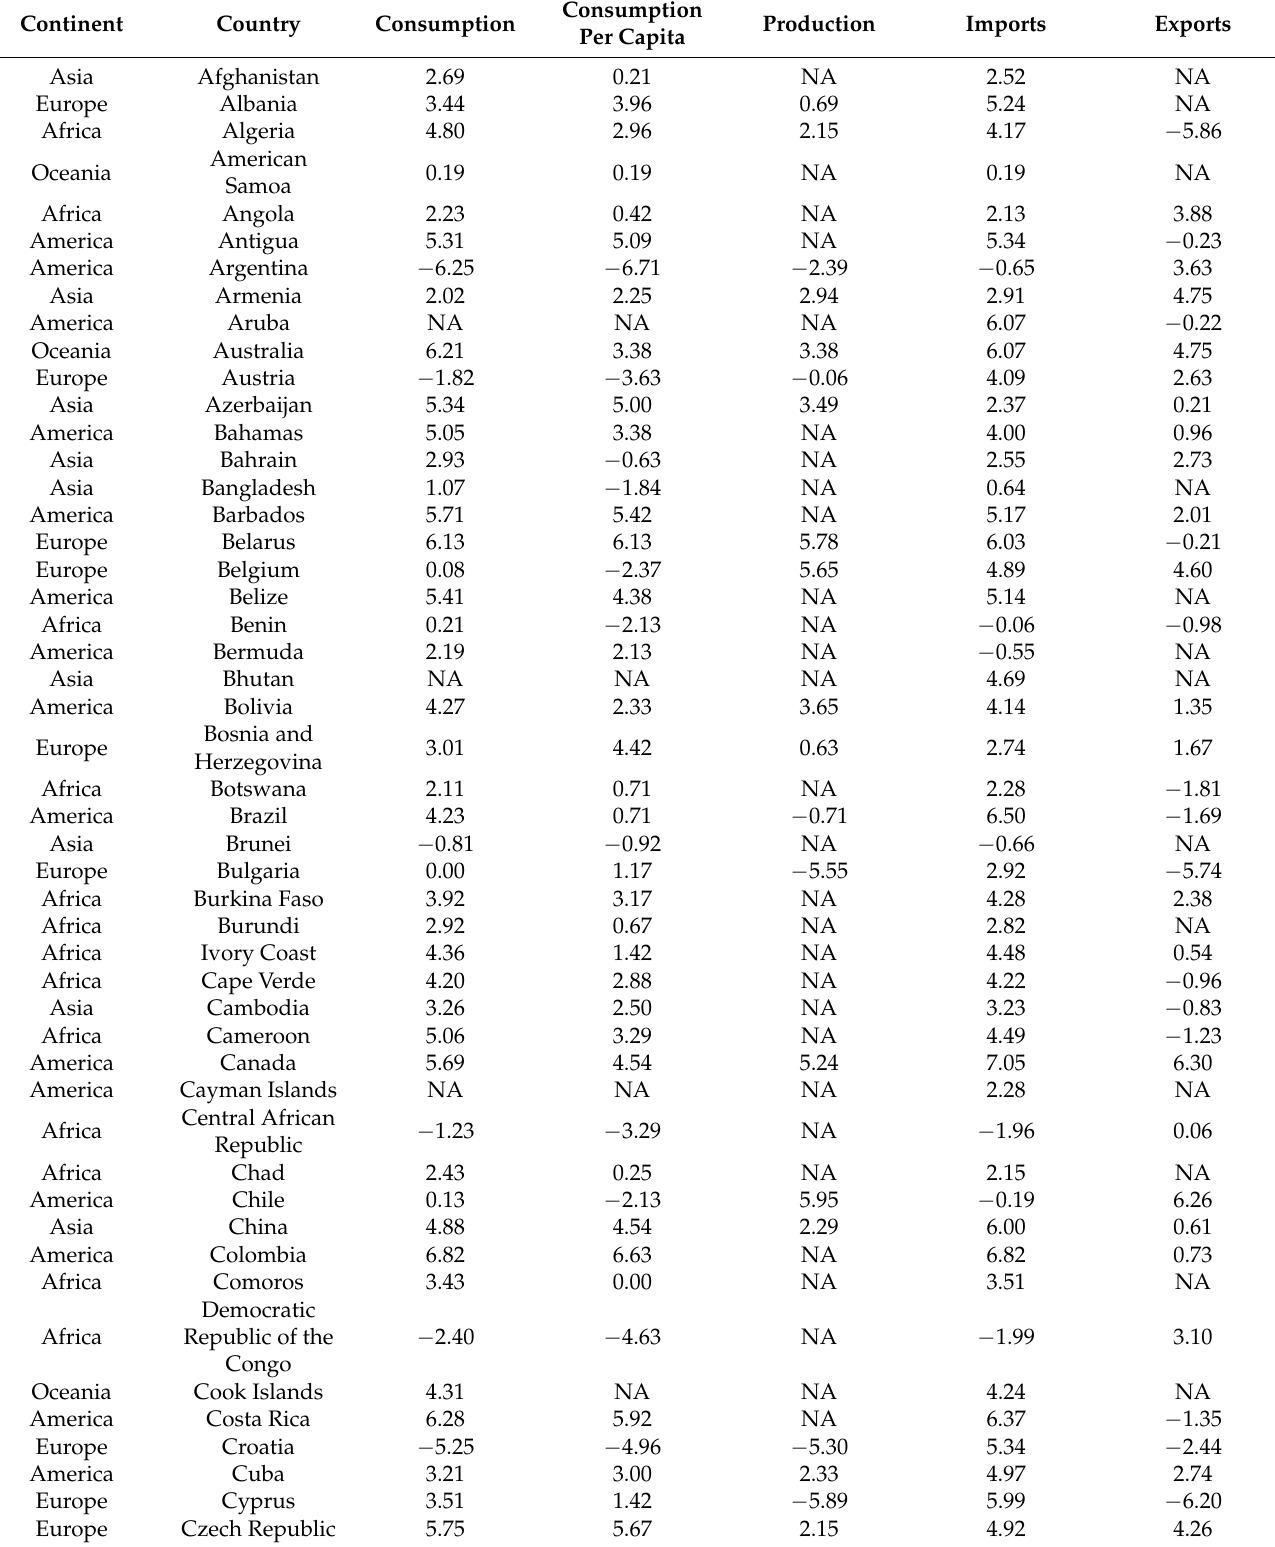
Table A2. Z-score values resulting from the Mann-Kendall trend test, calculated for wine consump- tion, consumption per capita, production, imports, and exports for each country. Values above 1.96 and below − 1.96 are considered significant ( α =